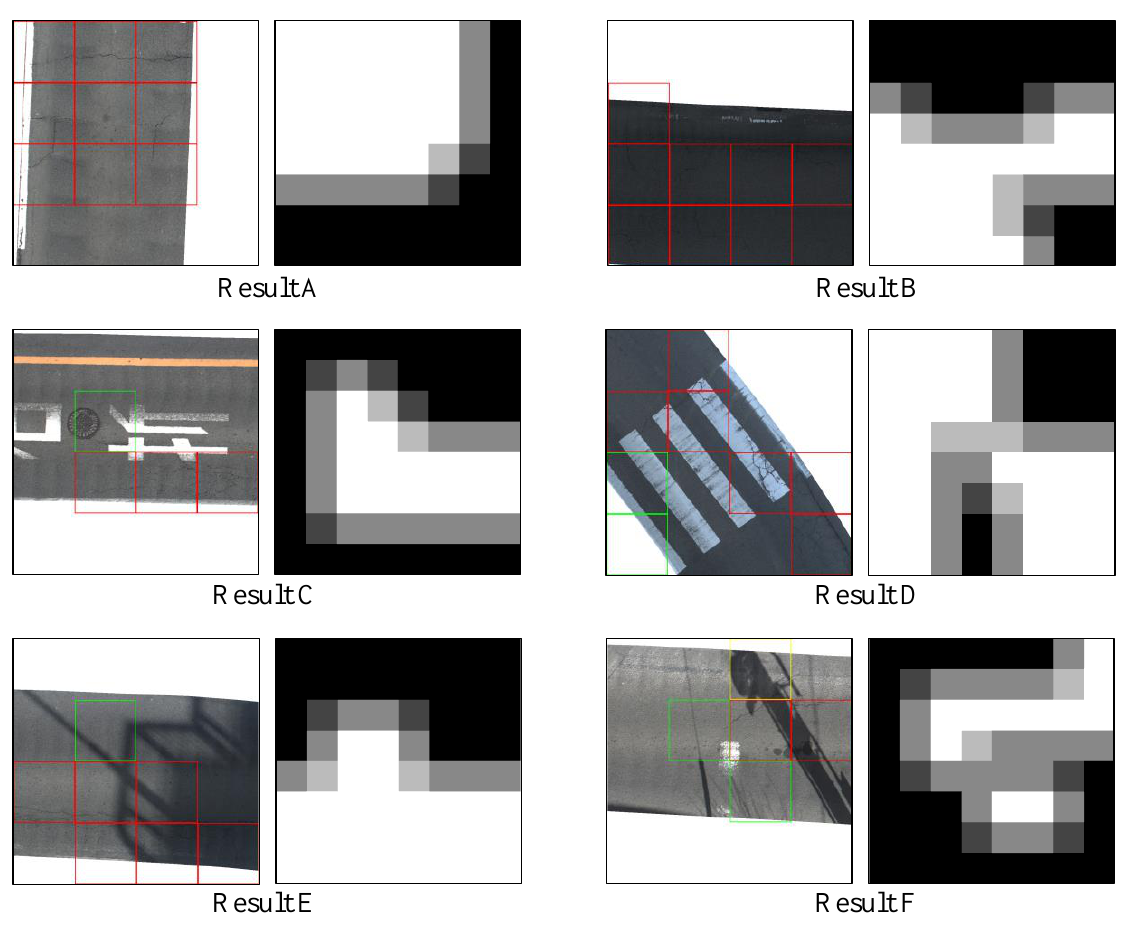
Figure 11. Crack detection results.